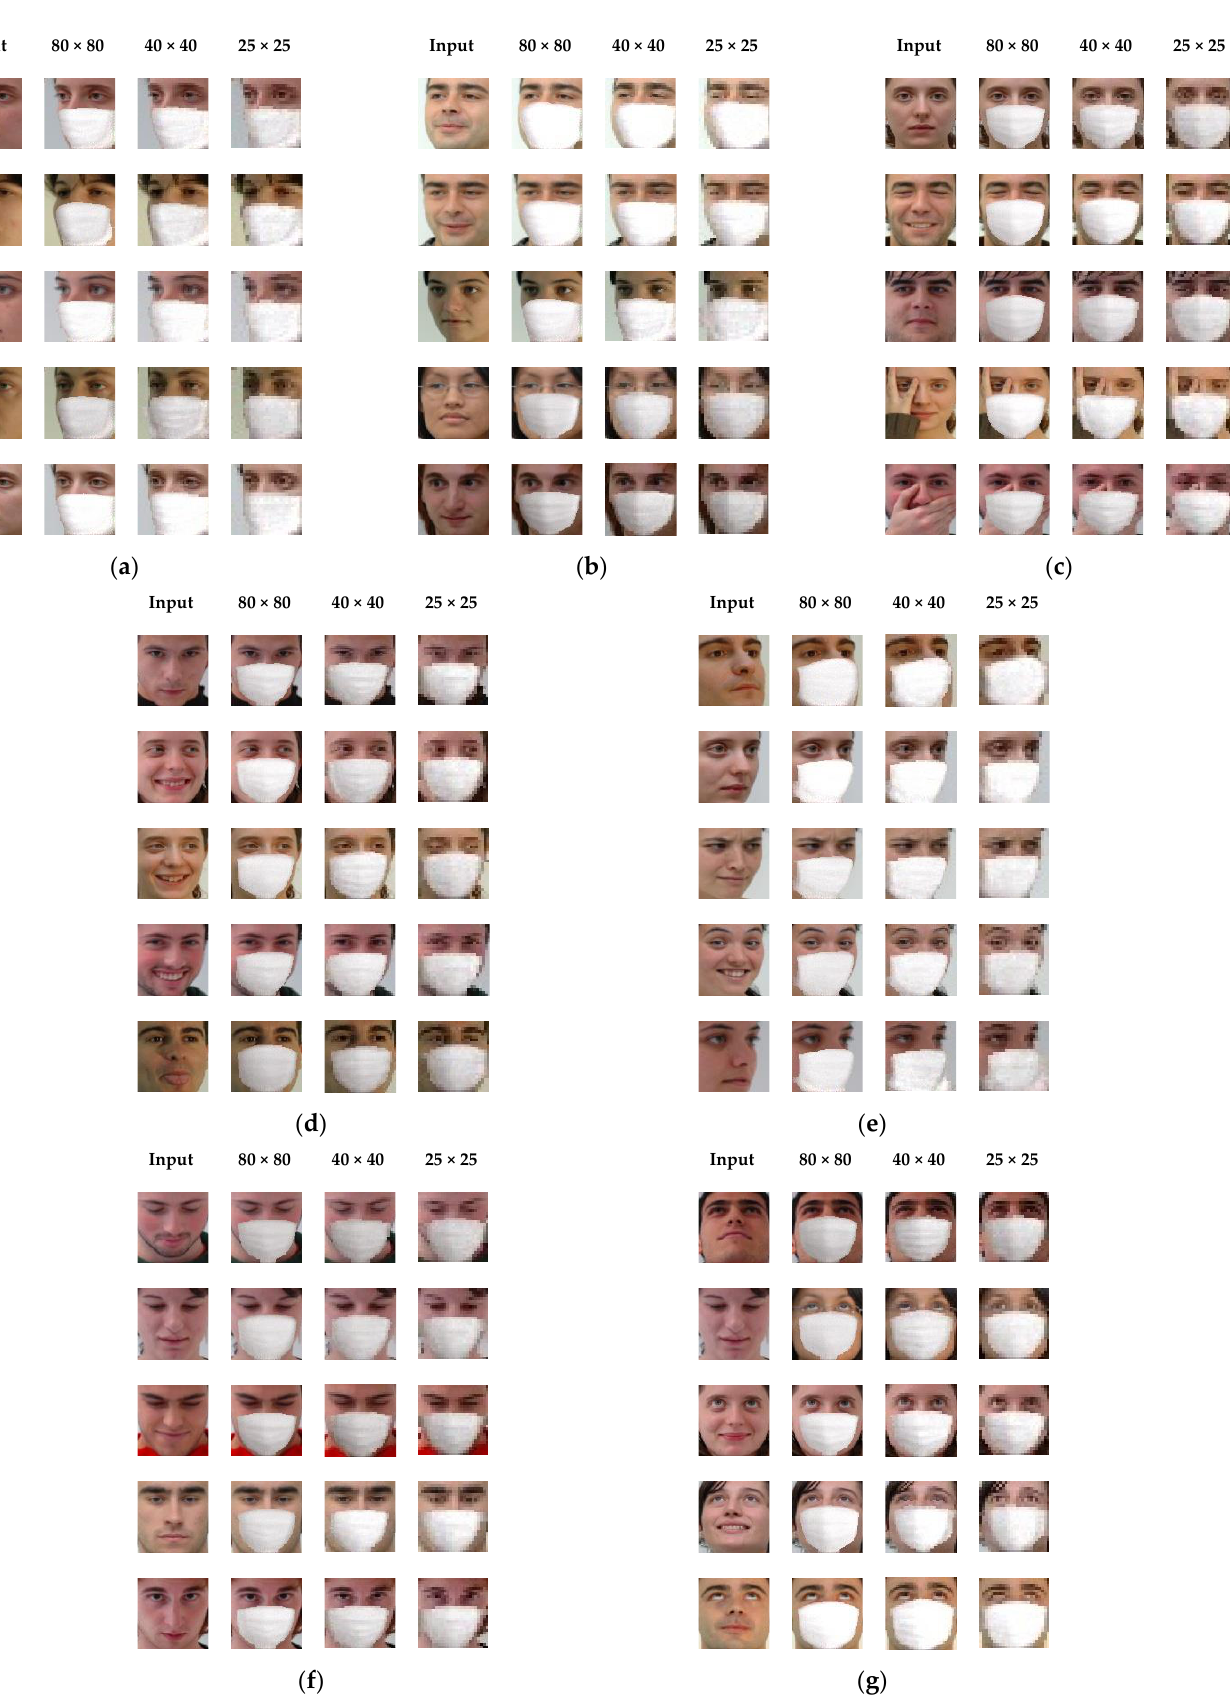
Figure 6. Results for different facial poses and resolutions. ( a ) − 45~60 degrees. ( b ) − 15~30 degrees. ( c ) frontal. ( d ) +15~30 degrees. ( e ) +45~60 degrees. ( f ) down. ( g )